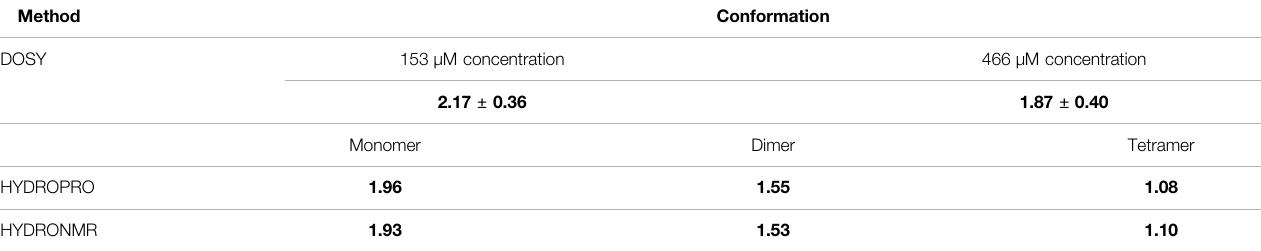
TABLE 1 | Experimental and calculated diffusion coef fi cients (D, *10 -10 m 2 /s) of T. maritima RNase P protein.